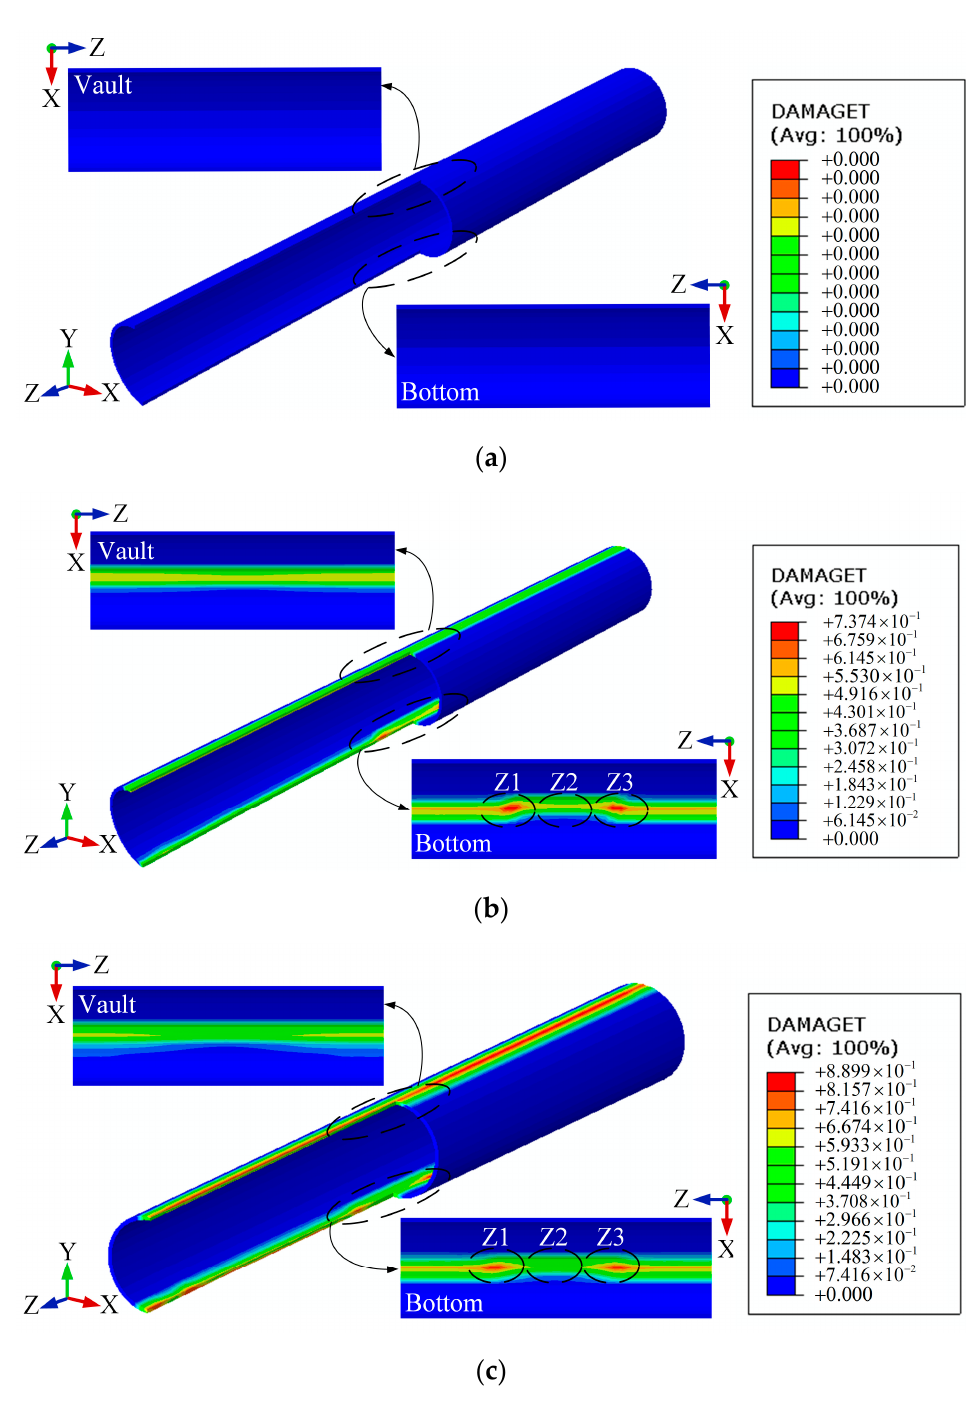
Figure 14. Tunnel’s damage diagram and details of the vault and bottom at different incident angles: ( a ) tunnel’s damage at incident angle of 10°, ( b ) tunnel’s damage at incident angle of 20°, and ( c ) tunnel’s damage at incident angle of 30°.